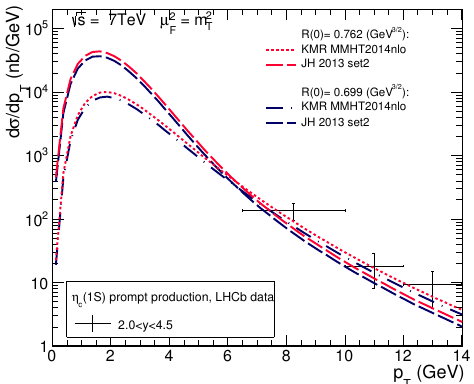
Figure 11 . Di(cid:11)erential cross section for prompt (cid:17) c (1S) production in the NRQCD approach. R (0) = 0 : 699 GeV 3 = 2 is extracted from experimental radiation decay width using relation (2.45) from [15] and NLO expansion (see eq. (2.22)). For comparison, we also show the results for R (0) = 0 : 762 GeV 3 = 2 (the value which was obtained in [15] for power-law potential.